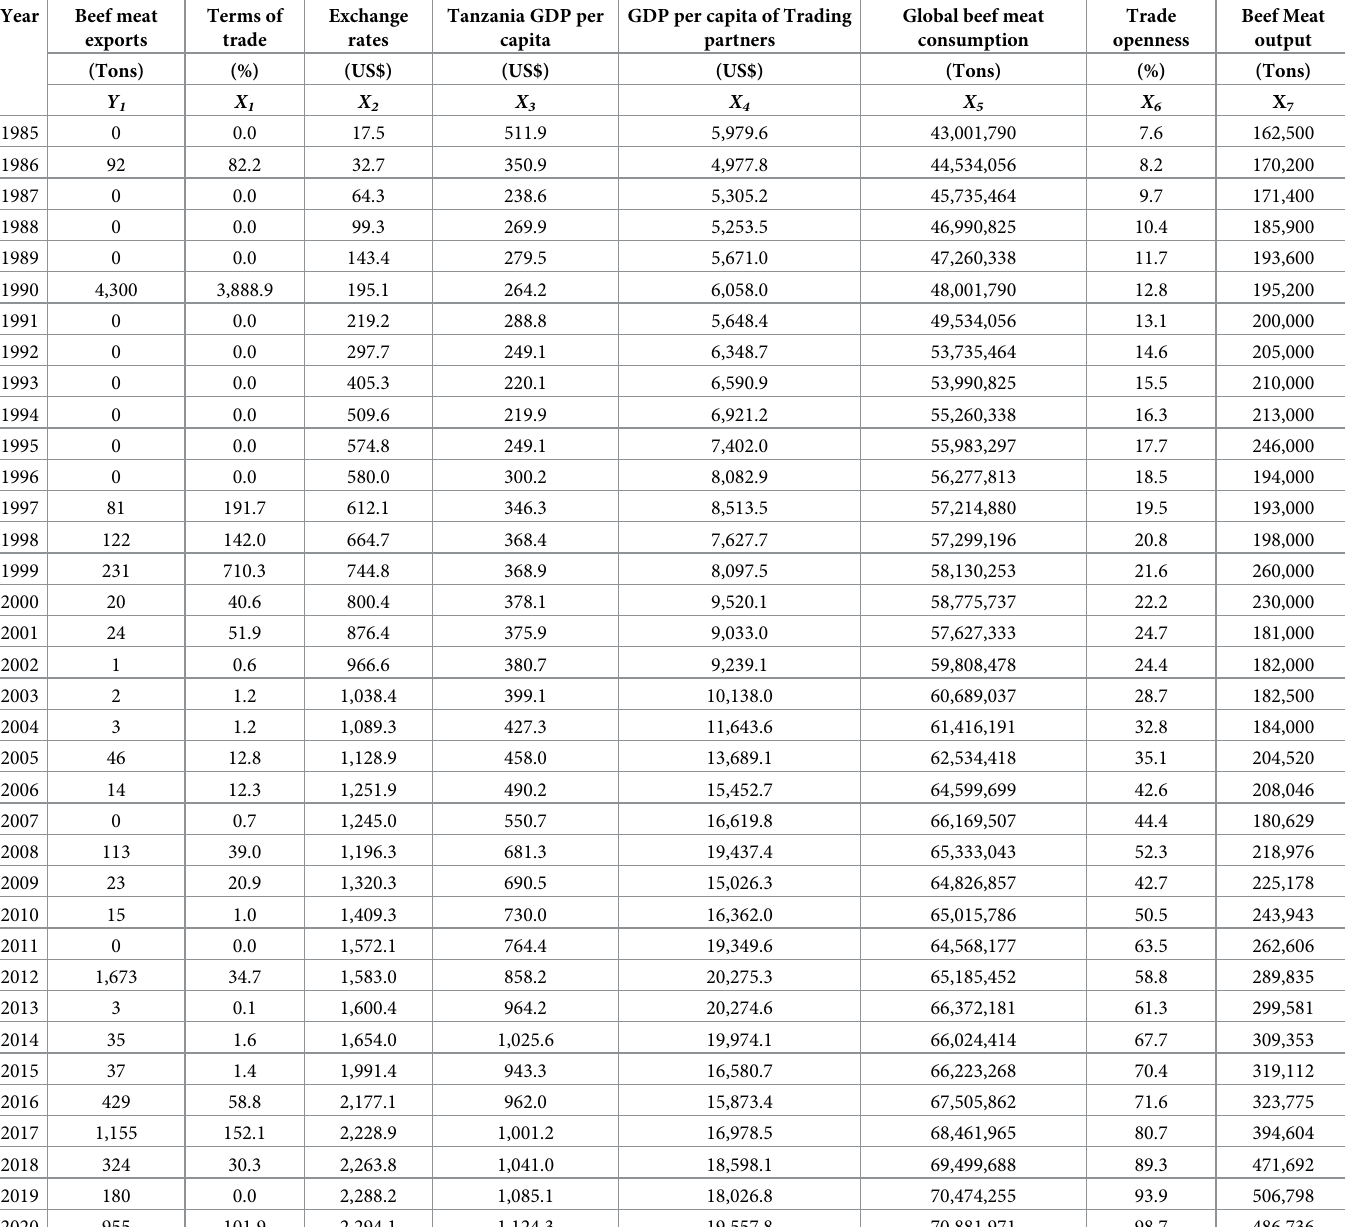
Table 2. Original